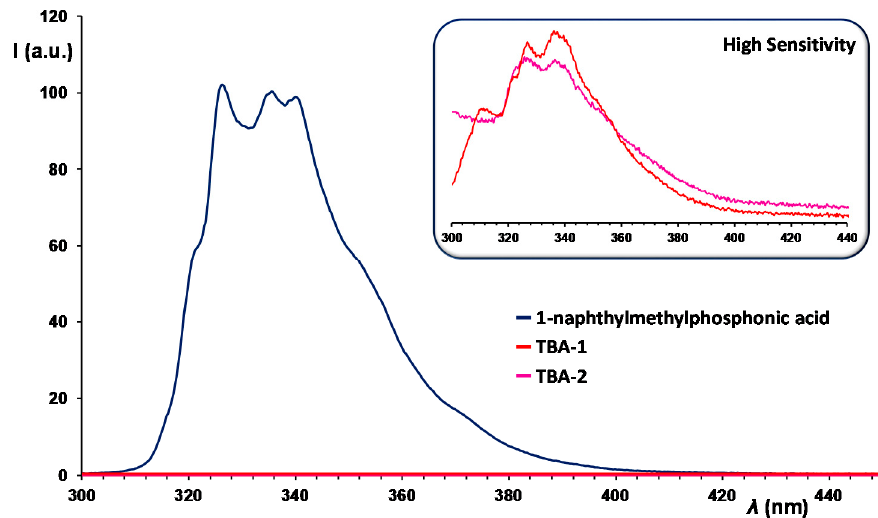
Figure 8. Fluorescence emission spectra of 10 − 6 M acetonitrile solutions of TBA-1 , TBA-2 and 1-naphthylmethylphosphonic acid in the 300–450 nm region ( λ exc = 283 nm).